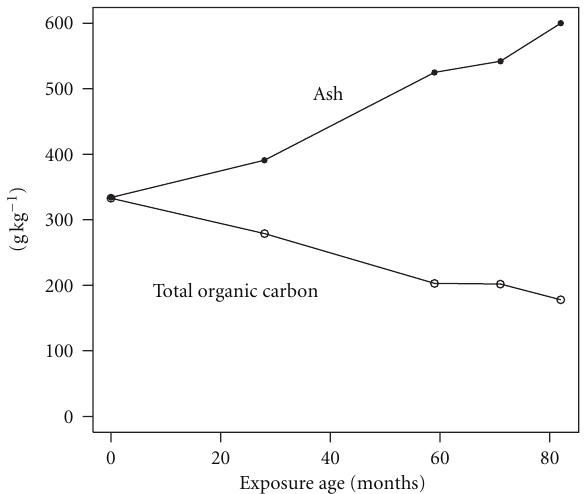
Figure 16: Ash and total organic carbon content in biosolids as a ff ected by age of exposure on the soil surface (redrawn from